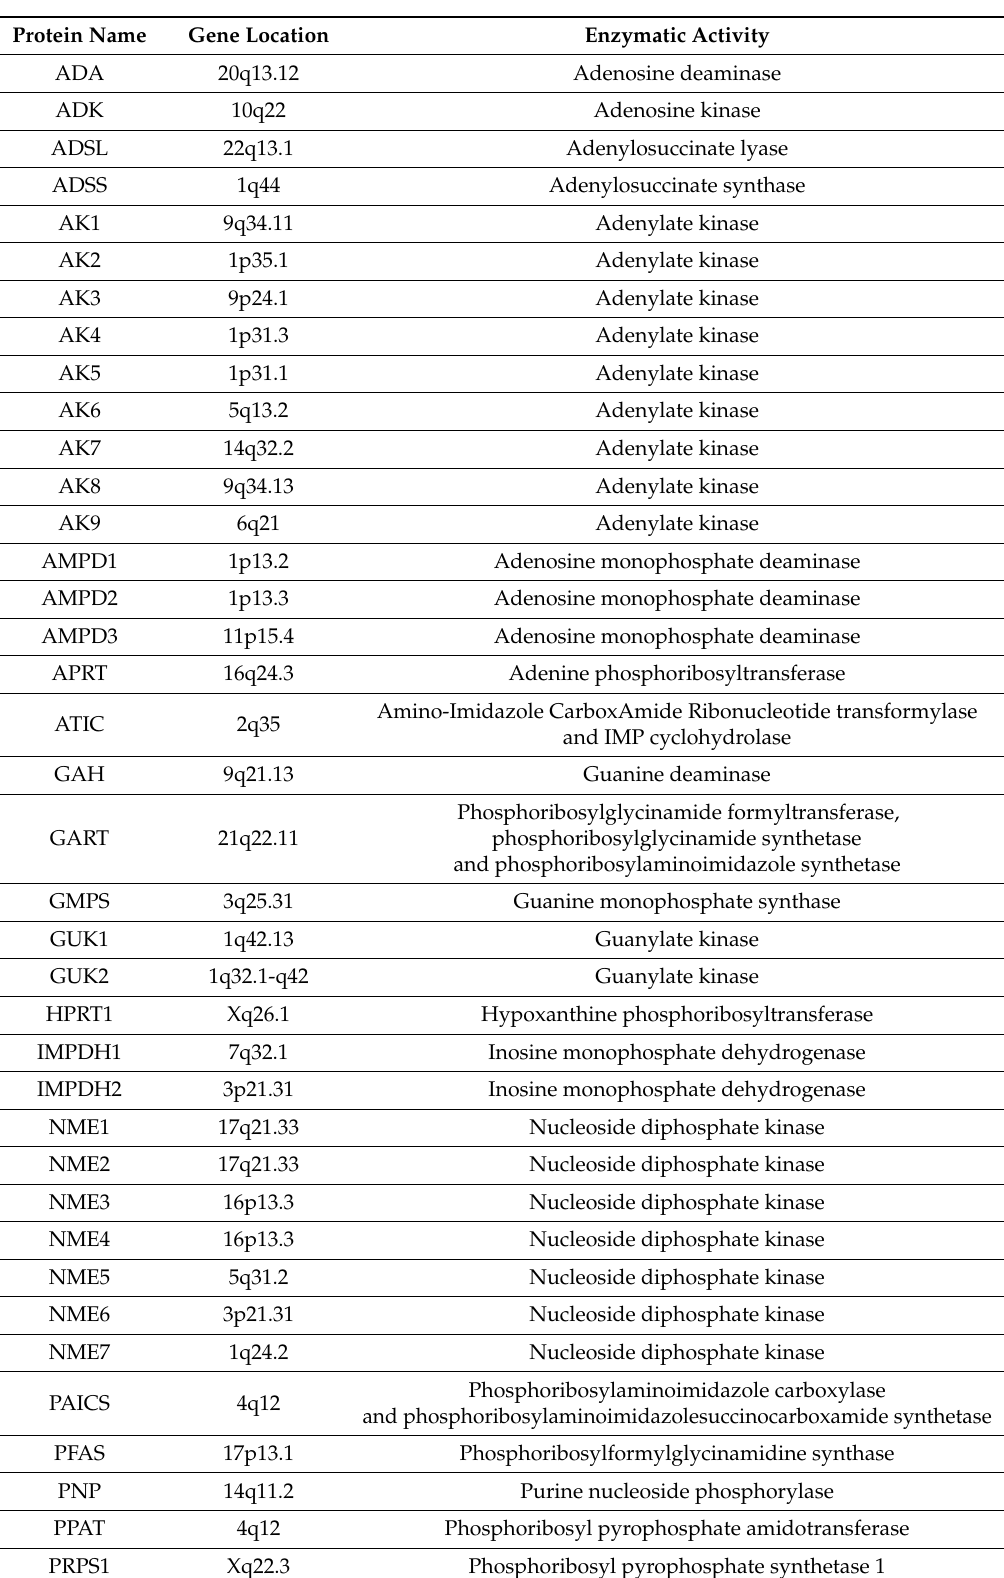
Table A2. List of the human purine pathway enzymes shown in Figure 1. Enzyme features were obtained from the NCBI web site